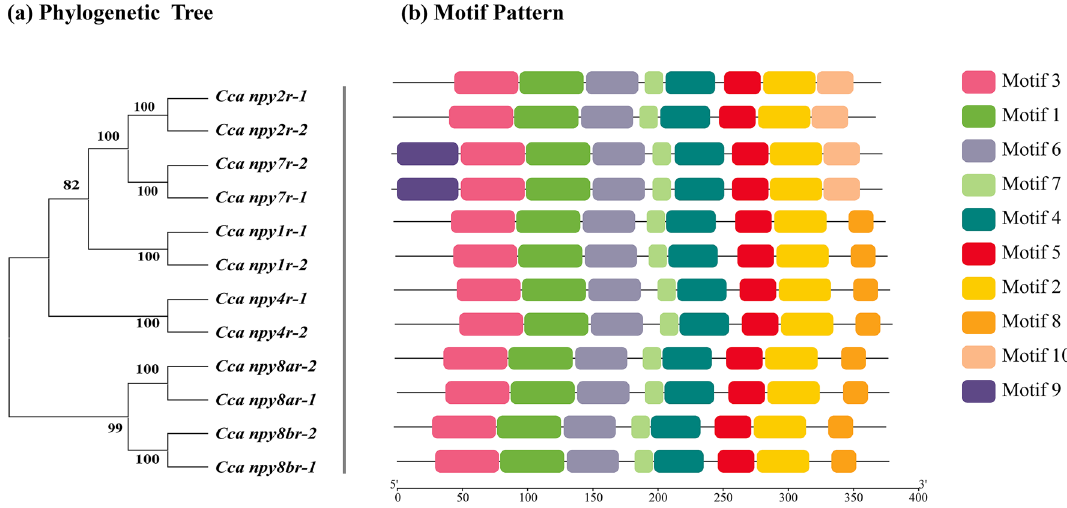
Figure 3. Phylogenetic tree and motif analysis of NPY-family receptor genes in allotetraploid C.carpio . ( a ) The phylogenetic tree of NPY-family receptor genes in allotetraploid C. carpio . ( b ) Sequences analysis of